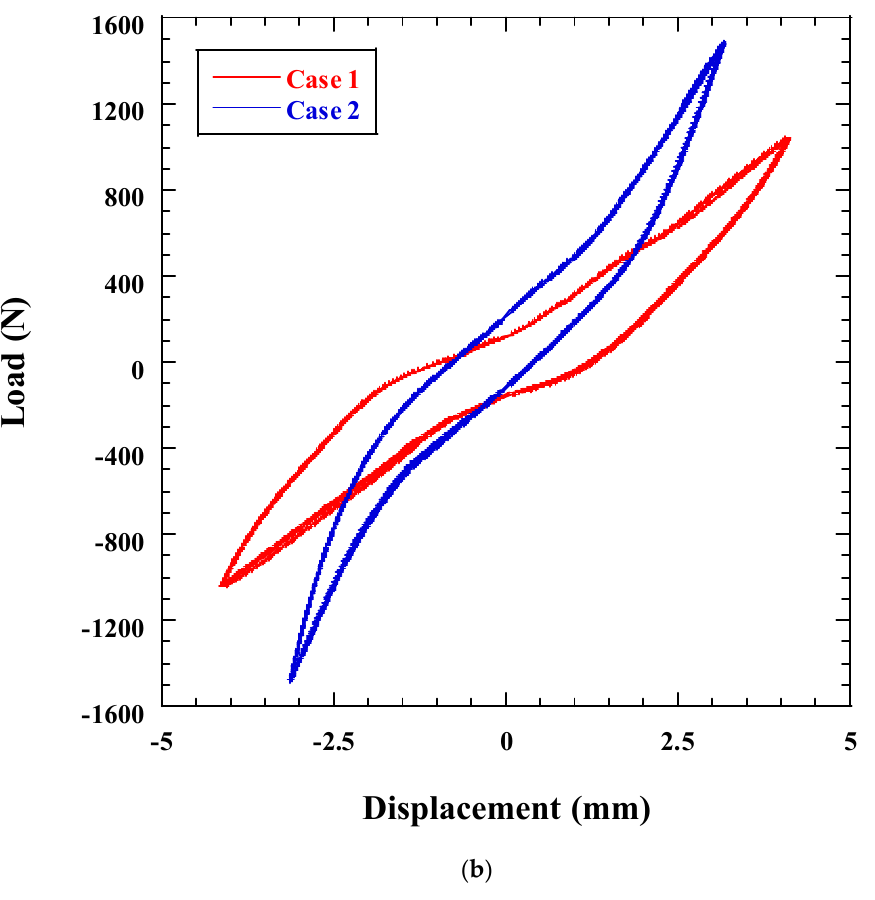
Figure 3. Static Load Test Results (( a ) Lateral Direction, ( b ) Axial Direction).